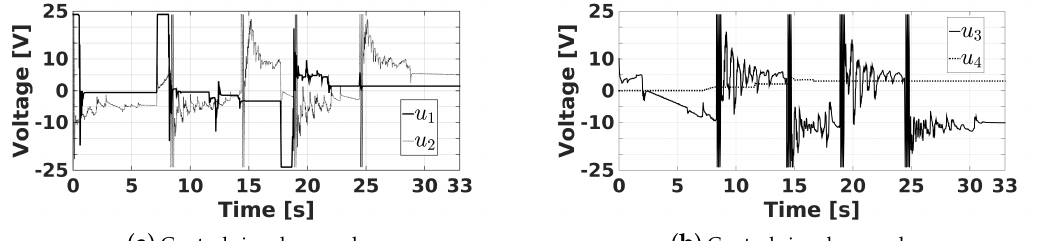
Figure 22. Control signals of the